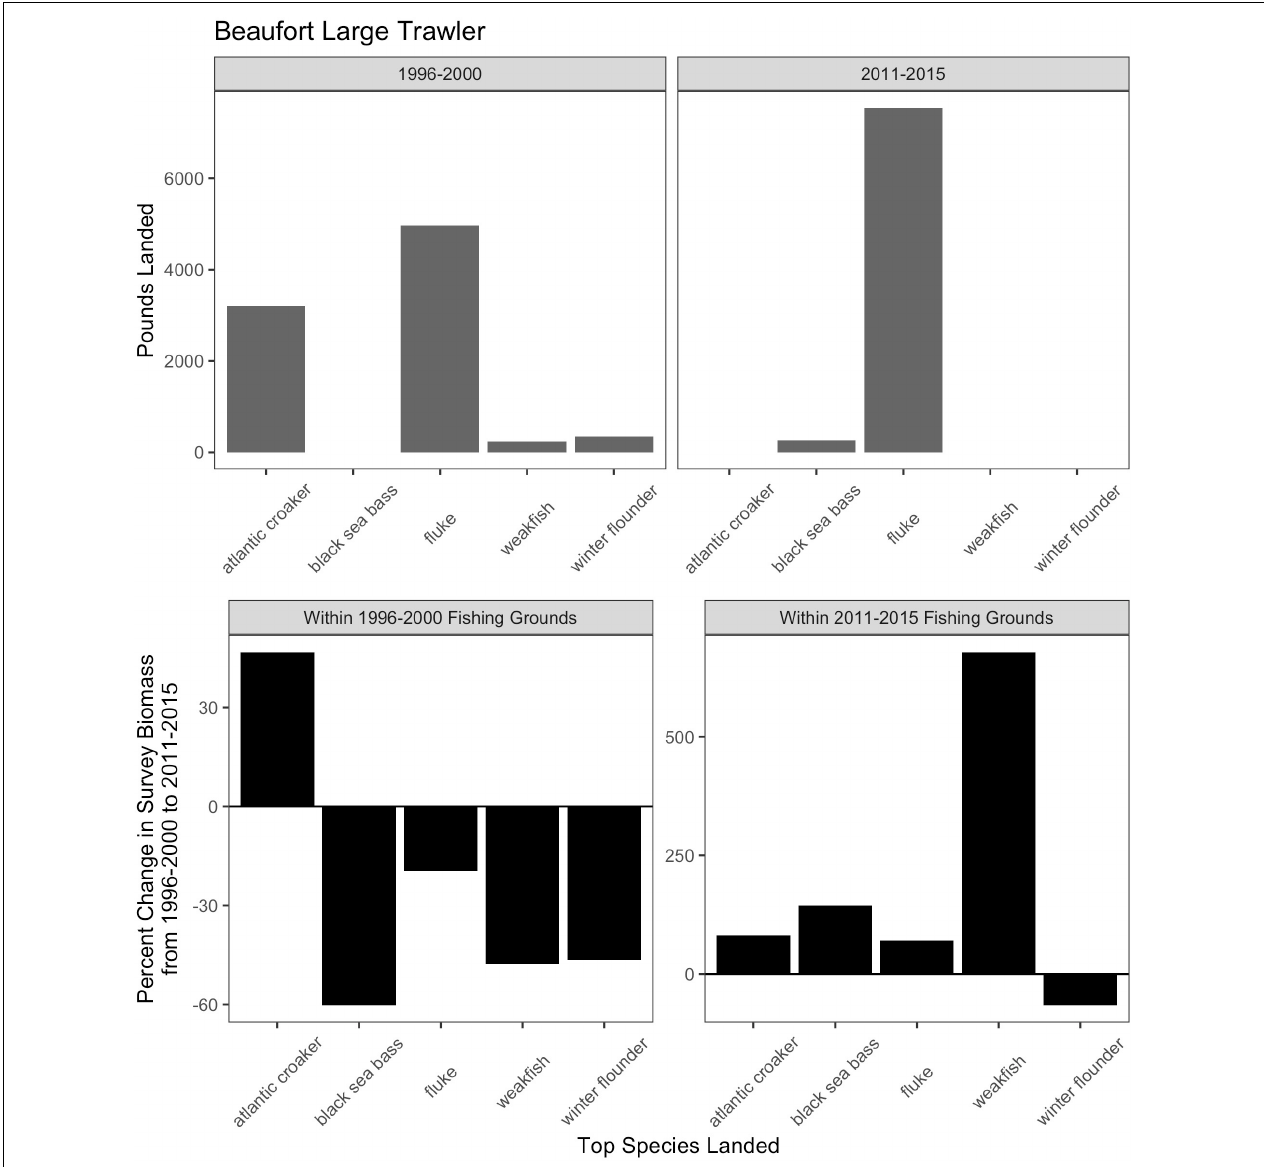
FIGURE 7 | Match and mismatch between changes in biomass and fishery catch in Beaufort, North Carolina large trawlers. (Top) The landed volume (lbs) for the top 5 species in the baseline (1996–2000) (left) and recent period (2011–2015) (right). (Bottom) The percent change in survey biomass between 1996–2000 and 2011–2015 observed within the fishing grounds in the baseline period (left) and in the recent period (right). Species scientific names: atlantic croaker = Micropogonias undulatus , black sea bass = Centropristis striata , fluke = Paralichthys dentatus, weakfish = Cynoscion regalis , winter flounder = Pseudopleuronectes americanus